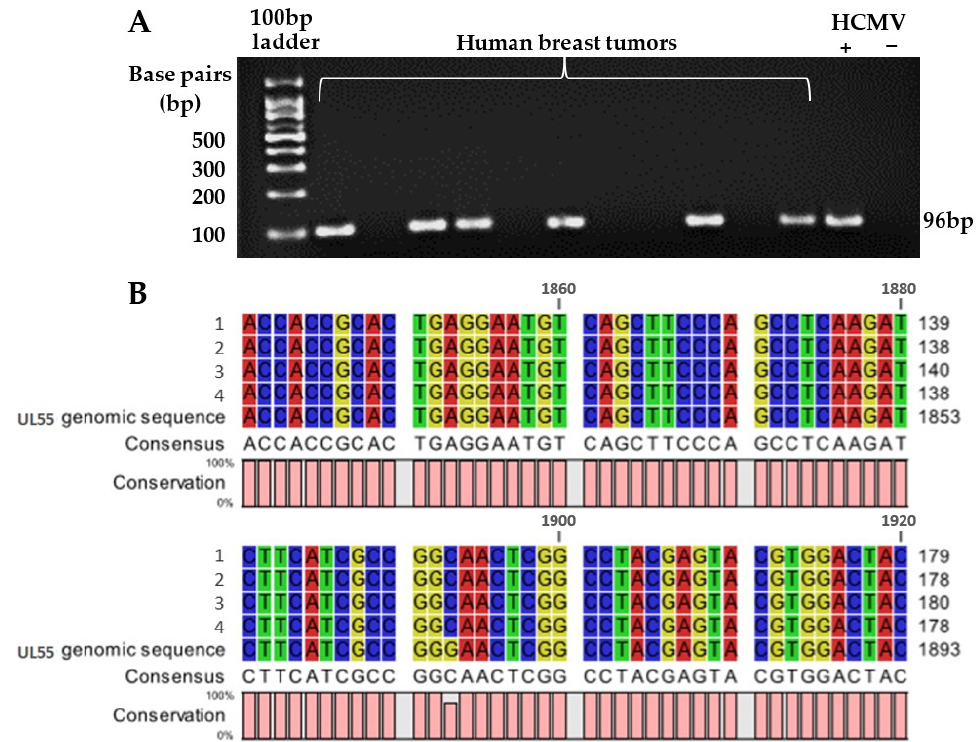
Figure 2. Specificity of HCMV glycoprotein (gB) DNA detection using nested PCR. PCR products for amplified HCMV gB gene from human breast tumor samples were visualized on 3% agarose gel stained with ethidium bromide, resulting in a band at 96 bp in the positive control and some human breast tumor samples ( A ). The PCR product at the 96 base-pair (bp) position was re-extracted from the gel and cloned for Sanger DNA sequencing, with the results aligned by comparing to the UL55 genomic sequence that encodes HCMV gB ( B ). Ten samples were analyzed and all aligned to UL55. Four of the samples were randomly chosen and illustrated in the sequence alignment map ( B ).